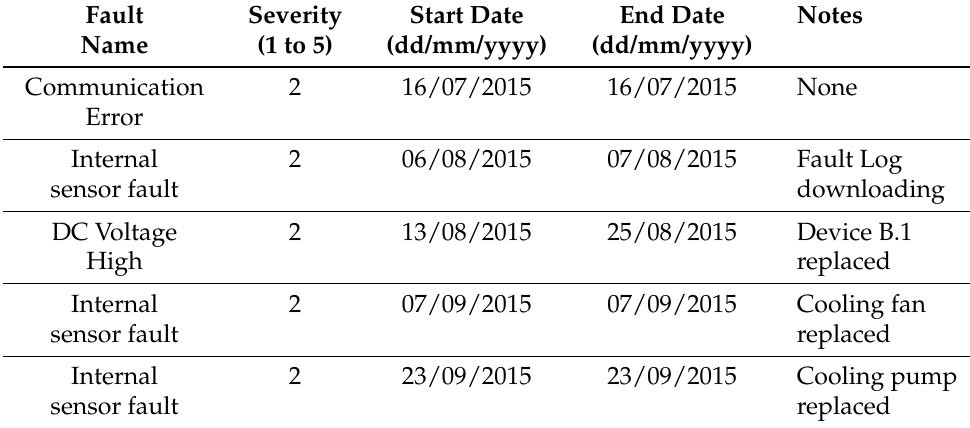
Table 6. Main failures occurred on inverter B.1 of plant B during the testing